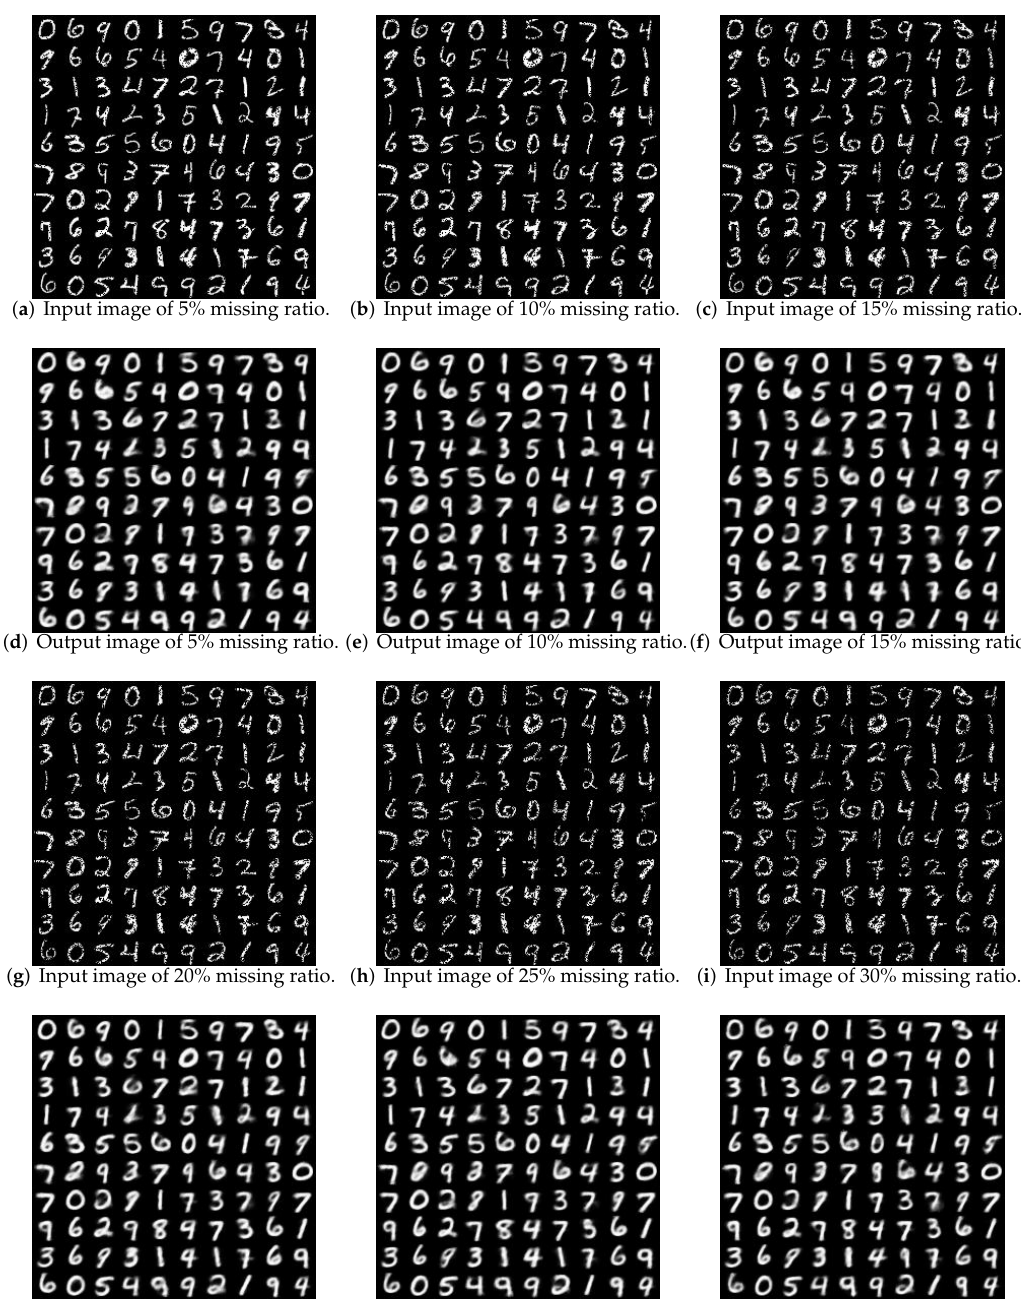
Figure 8. Reconstruction quality for different